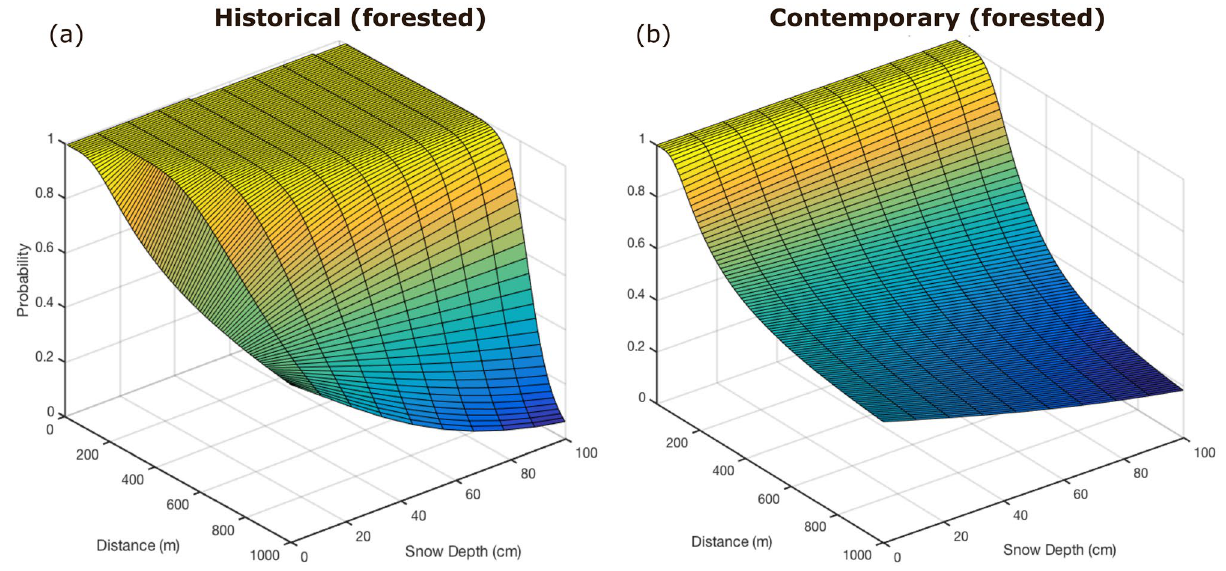
Figure 3. 3D prediction plots of relative probability-of-use of forested habitats (for unforested habitats, see Fig. S3.1) in the two periods (1999–2002: ( a ); 2012–2015: ( b )) covered by the